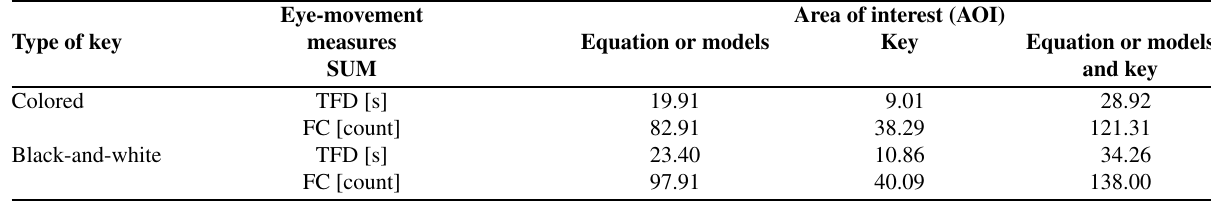
Table 3. Sum of the mean values of TFD and FC for tasks that involve colored or black-and-white explanatory keys.